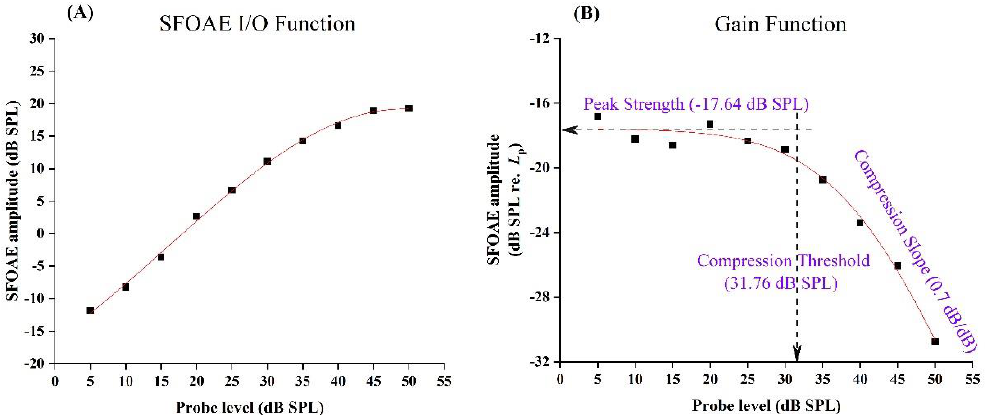
Figure 5. The SFOAE input / output function and the gain function at 4 kHz for one subject. ( A ) The SFOAE input / output function; ( B ) the SFOAE gain function. The gain function was transformed from the SFOAE input / output function by the SFOAE magnitude at each Lp subtracting (in dB) corresponding probe level. The red line represents the fitting curve of SFOAE strength. Three parameters—peak strength (PS), compression threshold (CT), and compression strength (CS)—were derived from this fit.